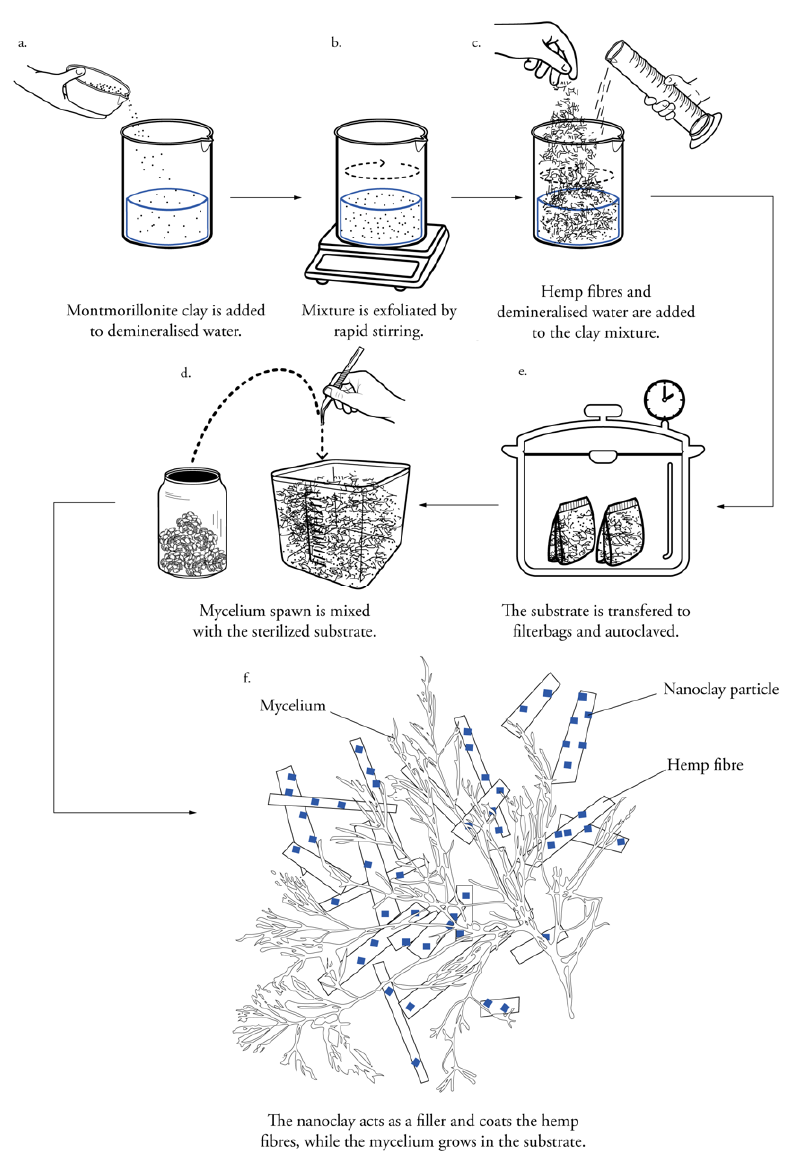
Figure 1. Schematic description of the fabrication process of nanoclay-reinforced mycelium compo- sites.